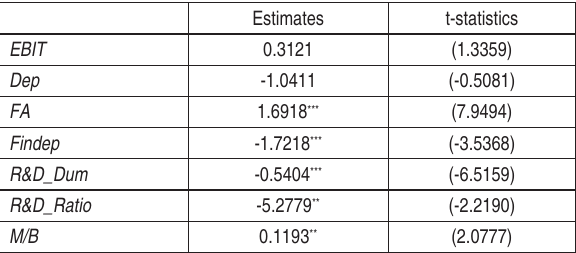
Table 4. Section of partial linear estimation in the SFE